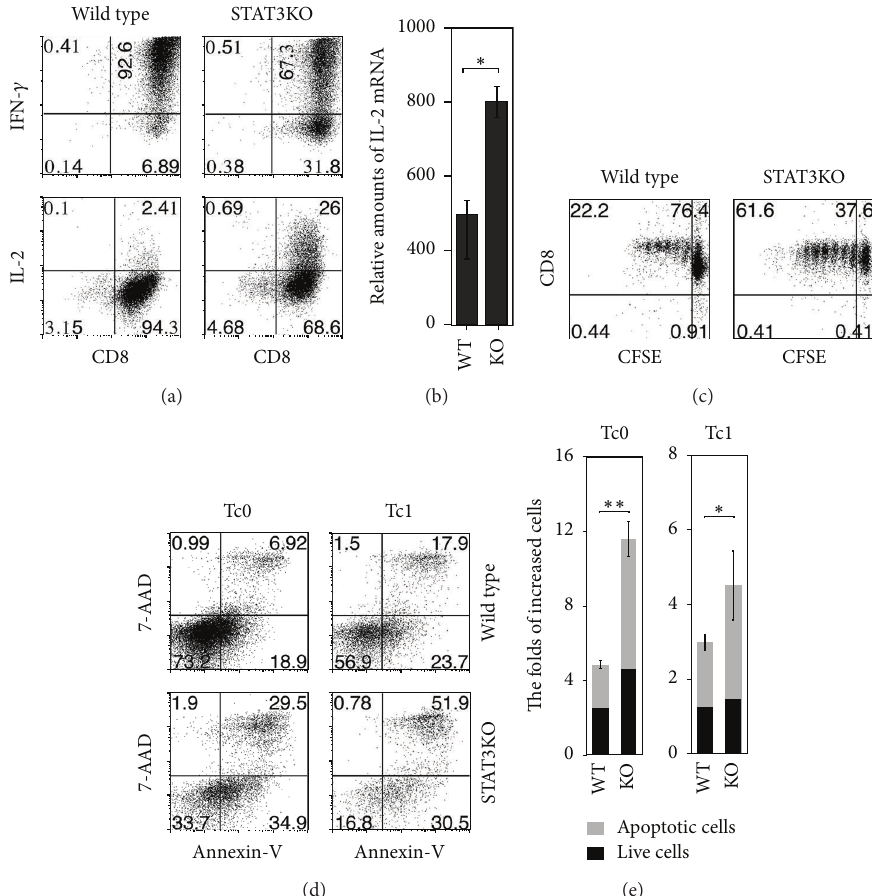
Figure 2: STAT3 inhibits CD8 + T cell proliferation and protects T cells from apoptosis. (a, b) WT or STAT3KO na¨ıve T cells were stimulated with anti-CD3/CD28 Abs under nonpolarizing condition for 4 days, and IL-2 or IFN- 𝛾 expression was detected and quantified by the intracellular cytokine staining assay (a) or RT-qPCR (b). (c) WT or STAT3KO T cells were stimulated in vitro with anti-CD3/CD28 Abs, and CFSE dilution analysis was performed after 4 d stimulations. (d) Na¨ıve CD8 + T cells were cultured under Tc0 or Tc1 condition for 4 days and stained with Annexin-V and 7-AAD. The cells undergoing apoptosis or necrosis were detected by FACS and cell counting using Vi-Cell XR cell-viability analyzer. (e) The relative percentages of apoptotic and viable cells were derived from the data shown in Figure 2(d) and statistically analyzed with Student’s t -test. Results are representative of 3 independent